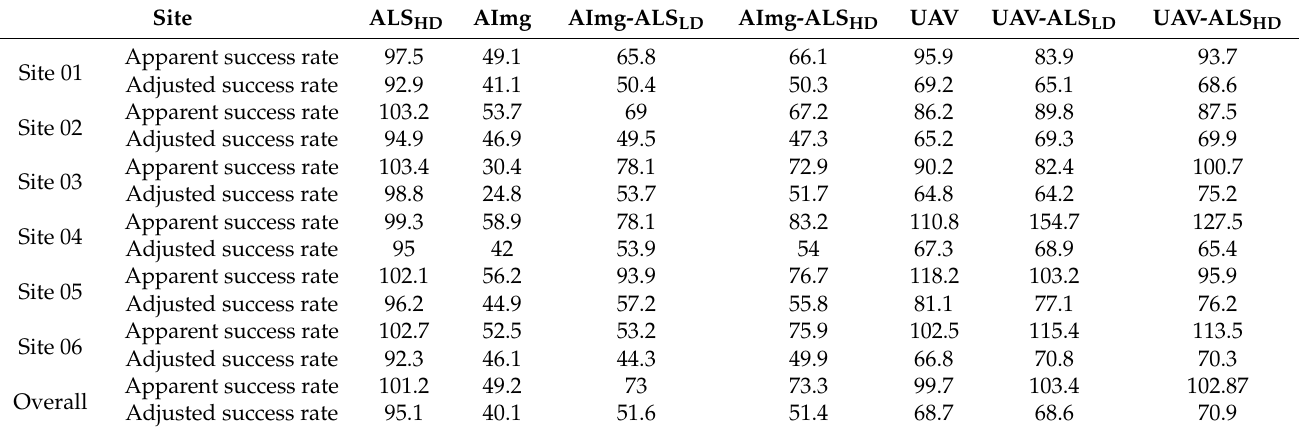
Table 4. The apparent success rate (%) of the automatic detection of the trees/shrubs over 1 m in height (upper rows) and the rate (%) of correctly automatically identified trees/shrubs (bottom rows) for individual sites and nDSMs.